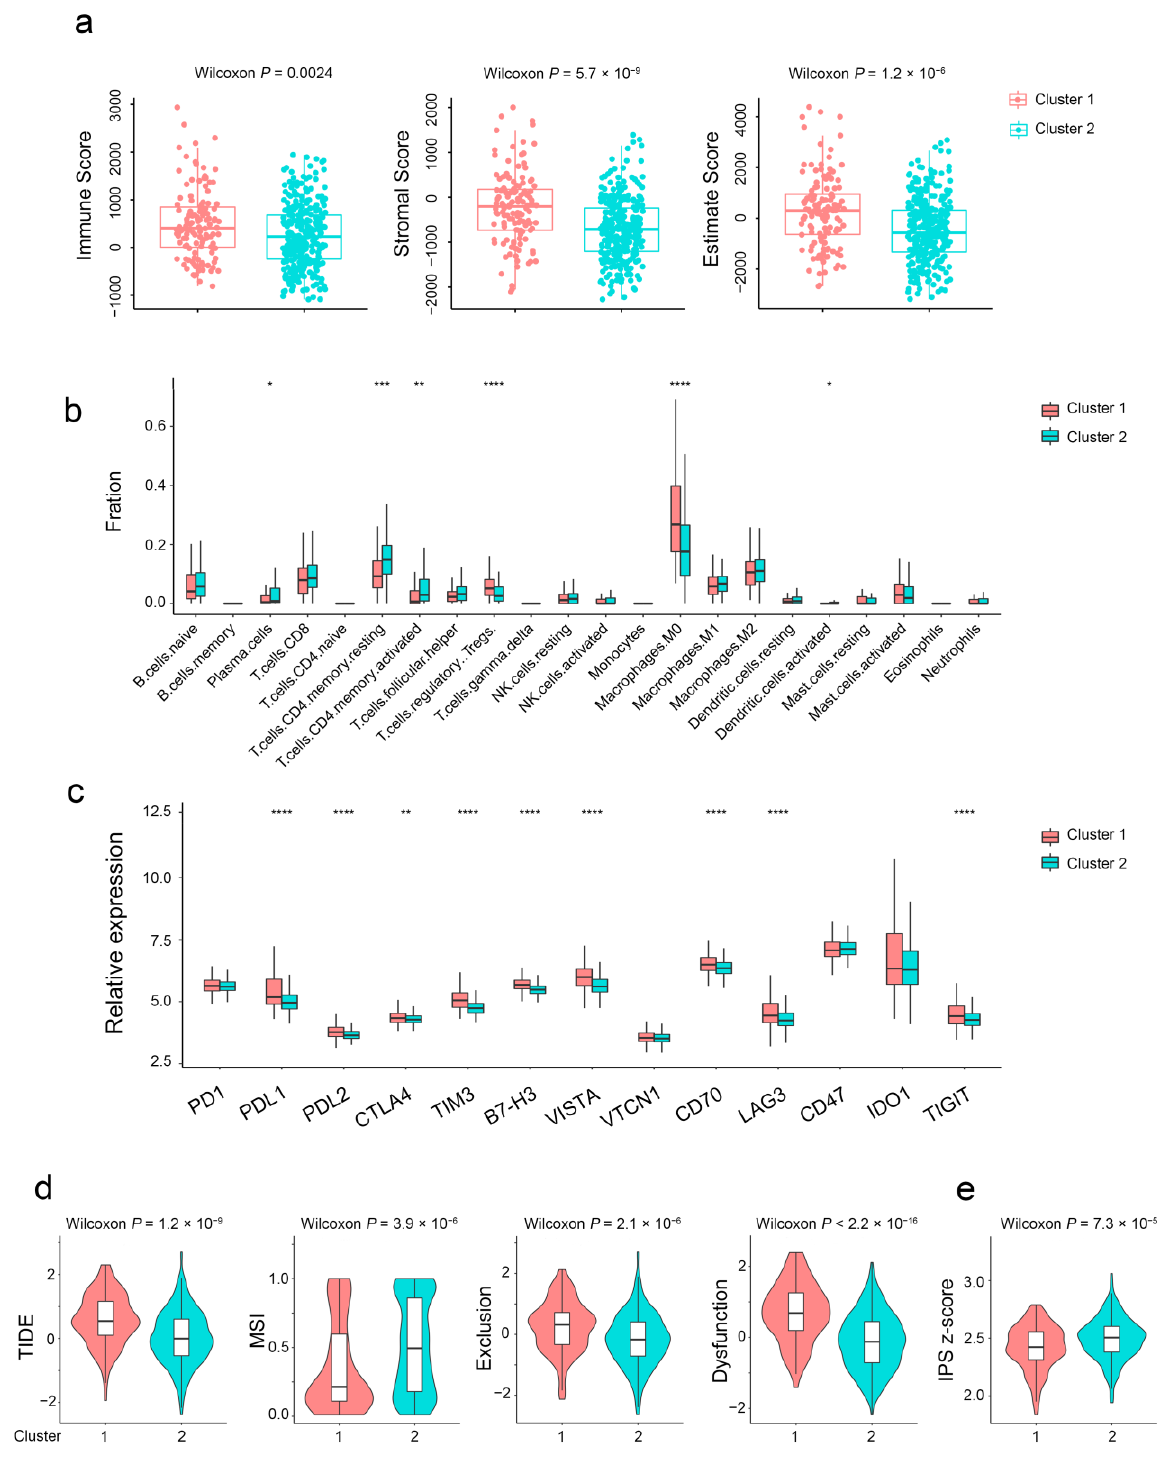
Figure 4. Immune characteristics of different aging subgroups. ( a ) Box plots of the immune, stromal, and estimate score between different aging subtypes. ( b ) Relative proportions of 22 immune cells in different aging subgroups. ( c ) Gene expression of immune checkpoints between two distinct clusters. ( d , e ) Violin plot of the TIDE and IPS score between two aging subtypes. *, p < 0.05; **, p < 0.01; ***, p < 0.001; ****, p <